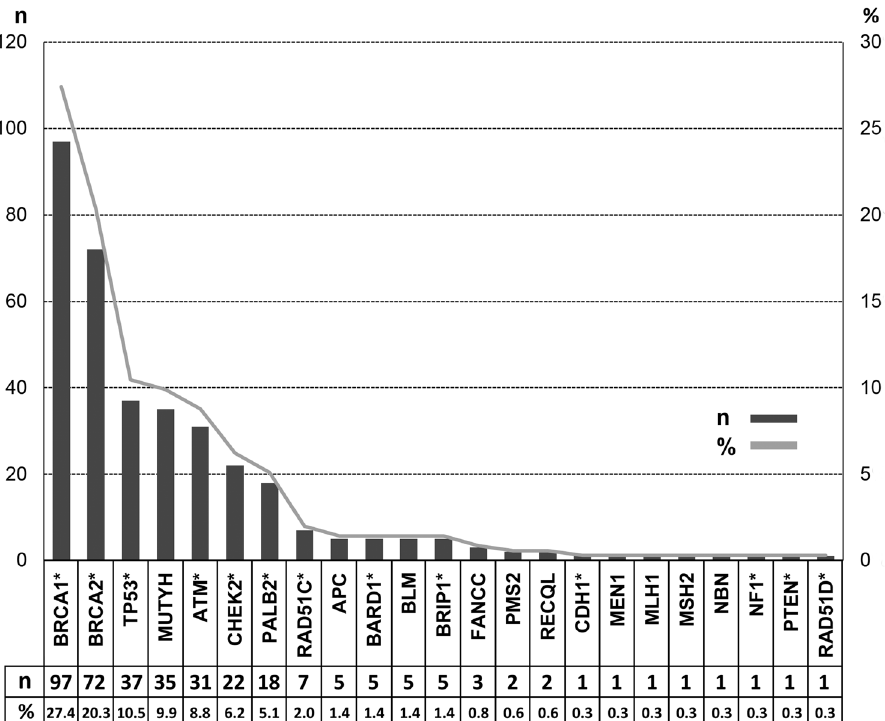
Figure 2. Mutation spectrum of pathogenic and likely pathogenic variants. *Clinically actionable breast cancer genes.